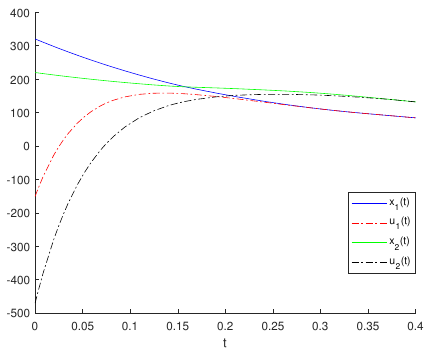
Figure 1. The curves of x 1 ( t ) , x 2 ( t ) , u 1 ( t ) , u 2 ( t ) from Example 1.